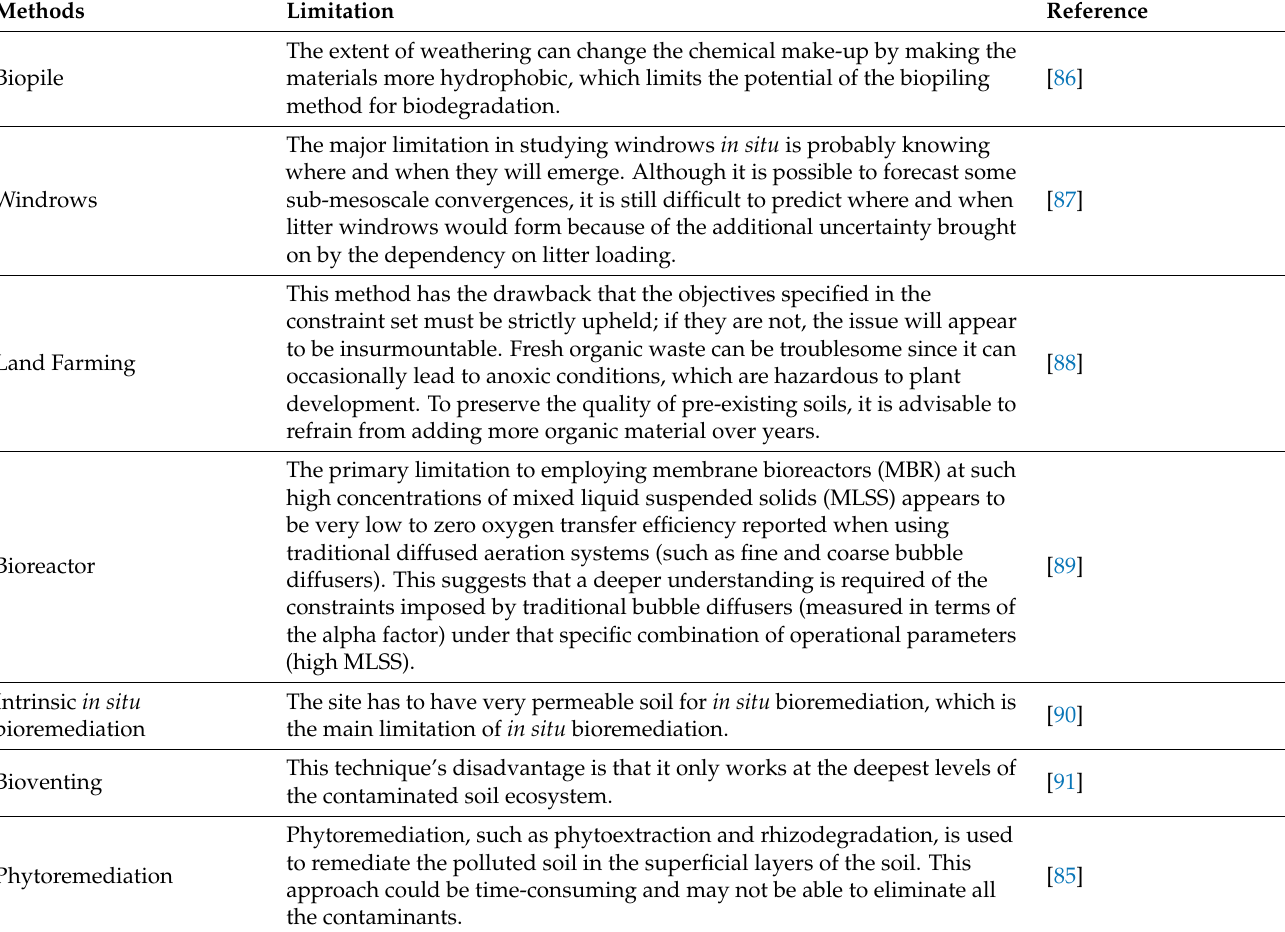
Table 2. Limitations of various bioremediation